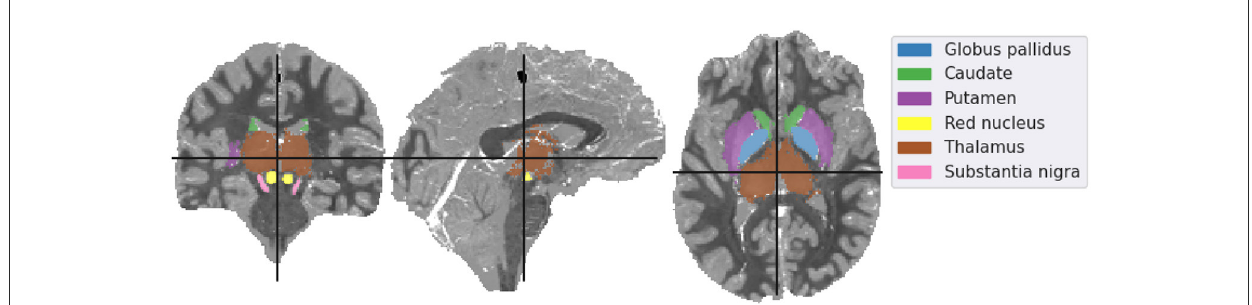
FIGURE2 Mid-plane slices of the ground truth magnetic susceptibility distribution of the QSM challenge dataset (QSM Challenge 2.0 Organization Committee et al., 2021). ROIs used in the analysis are denoted overlaid on the midplane slices. The colormap of the susceptibility distribution is identical to that of the other presented reconstructions, i.e., between –0.1 and 0.1 ppm.